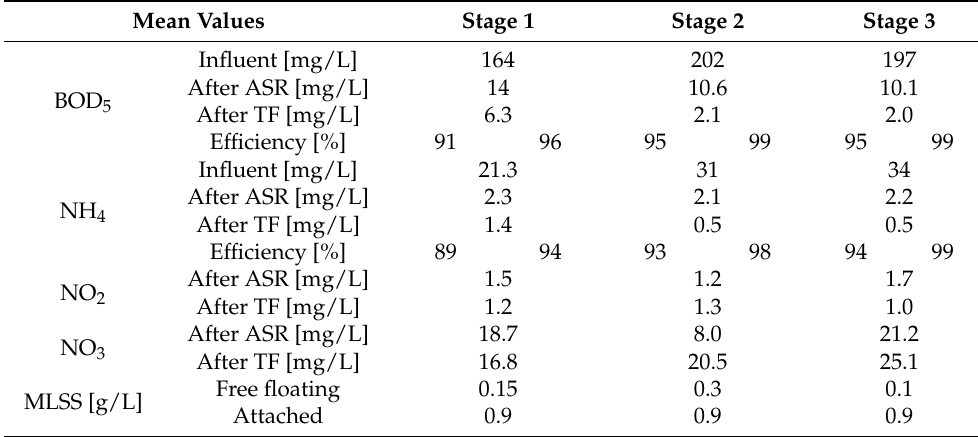
Figure 21. NO 3 dynamics: stage 1 (black); stage 2 (green); stage 3 (orange). Table 3. Comparison of treatment processes in stages 1, 2, and 3 of the research. Mean Values Stage 1 Stage